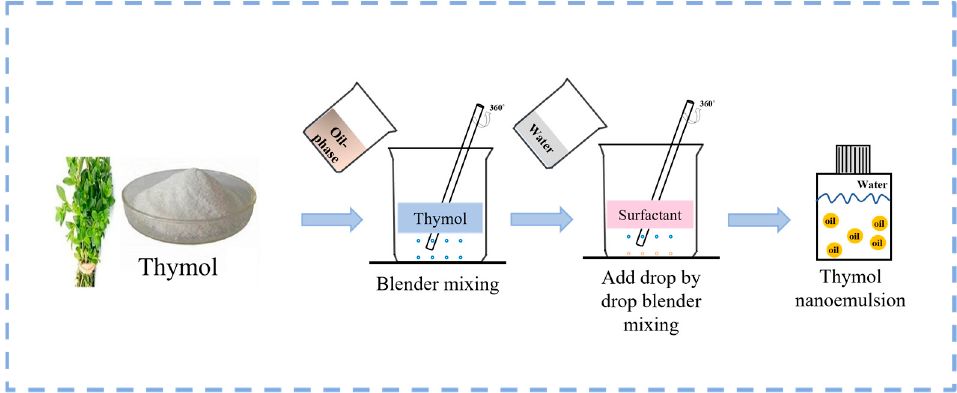
Figure 1. Schematic diagram for the preparation of Nano-Thy.